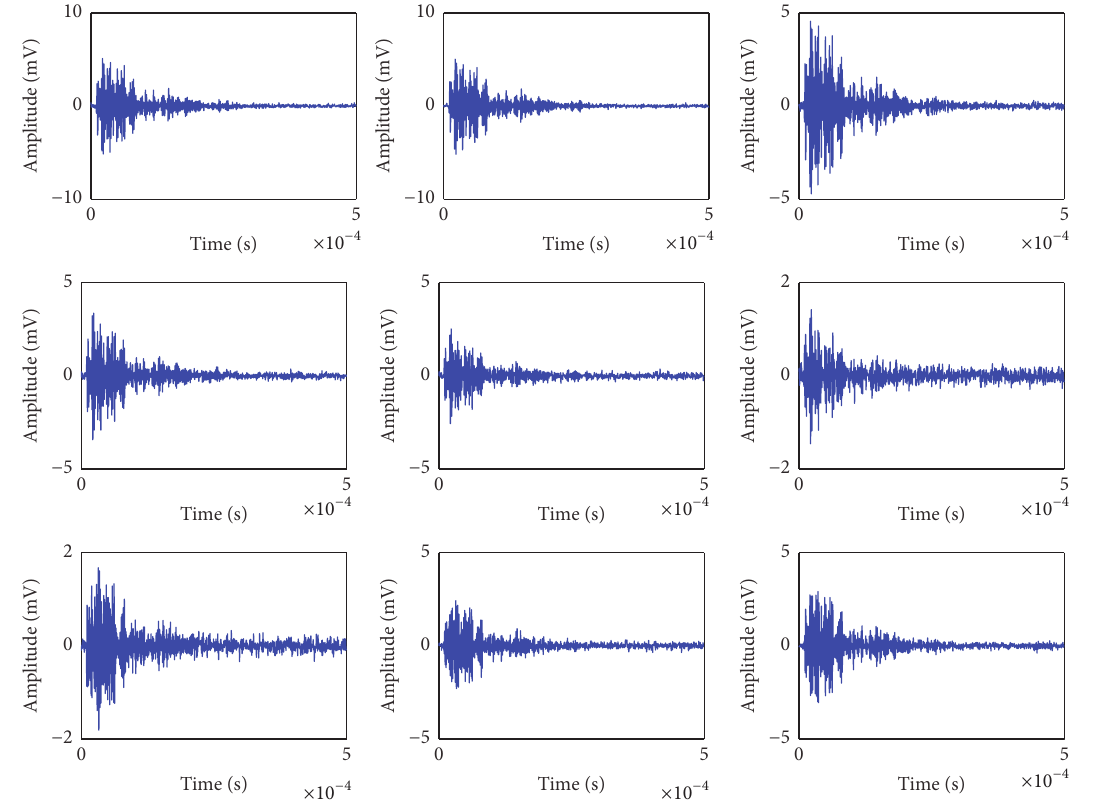
Figure 5: The oscillogram of the signal received by a full ultrasonic array.